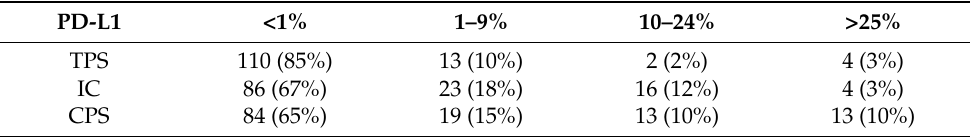
Figure 1. PD-L1 immunohistochemistry in gallbladder cancer and infiltrating immune cells. PD-L1 expression was evaluated on both the tumor and immune cells and expressed as Tumor Proportion Score (TPS), Immune Cell Score (IC) and Combined Positivity Score (CPS), respectively. Only membranous staining was counted. Upper panel: Representative microphotographs of negative ( A ) low (<10%); ( B ) high (>10%); ( C ) PD-L1 expression in the tumor cells. Lower Panel: Representative microphotographs of negative ( D ) low (<10%); ( E ) high (>10%); ( F ) PD-L1 expression in tumor infiltrating immune cells. Original magnification 400 × . Table 1. Overview of PD-L1 expression in the